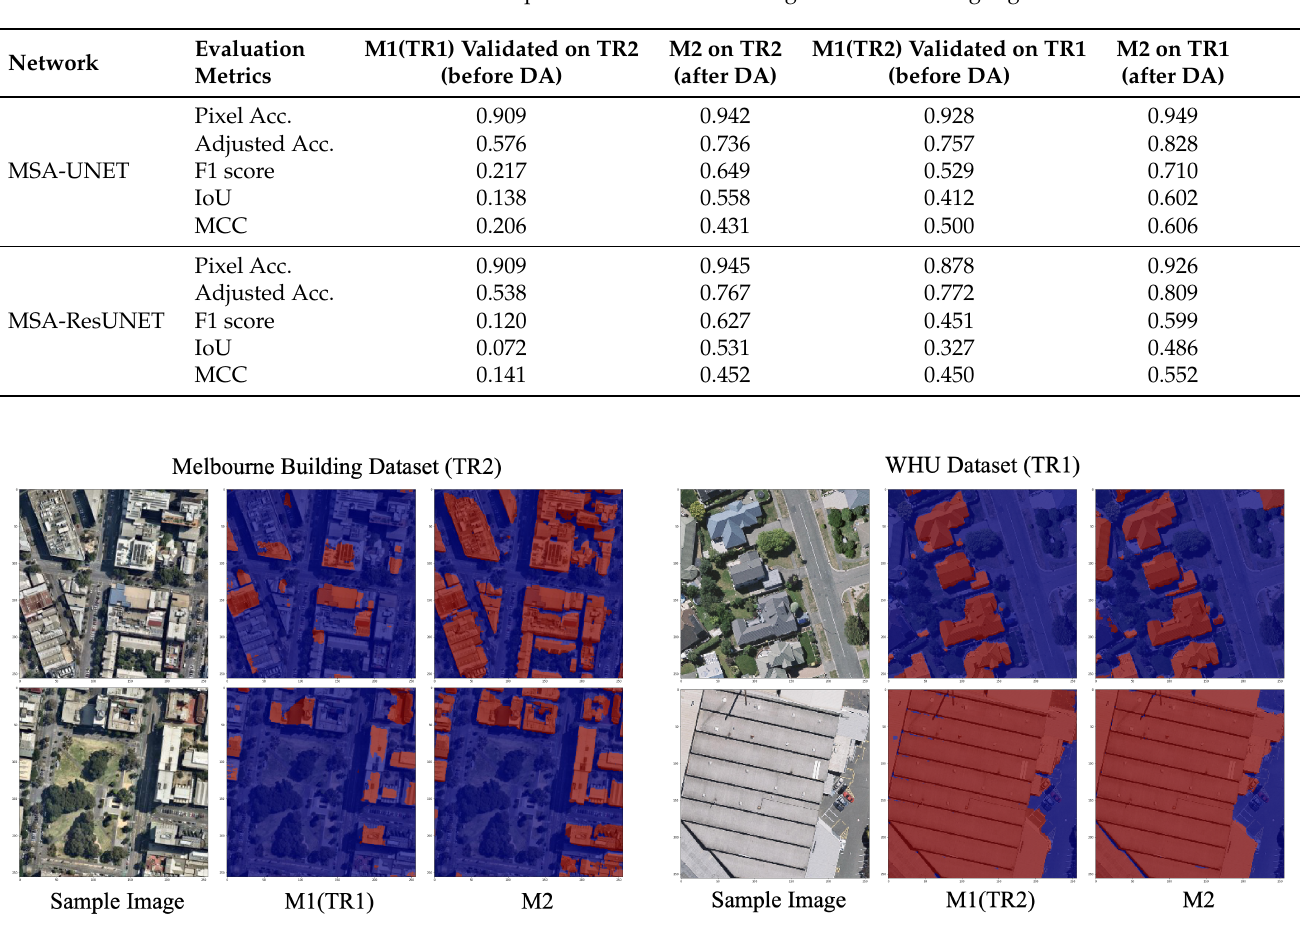
Table 5. Cross-domain validation results of MSA-UNET and MSA-ResUNET on TR1 and TR2. M1(TR1) and M1(TR2) refer to the base models trained on TR1 and TR2, respectively. M2 refers to the model previously trained on TR1 and supervised DA on TR2. The M1 and M2, therefore, provide before and after comparisons of the DA. The highest values are highlighted in bold.